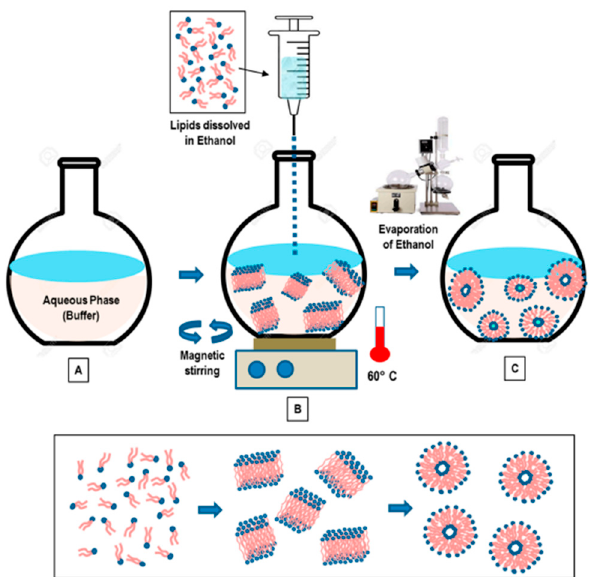
Figure 3. “Schematic representation of the main stages of the ethanol injection method” [9] [Reuse permitted by MDPI].